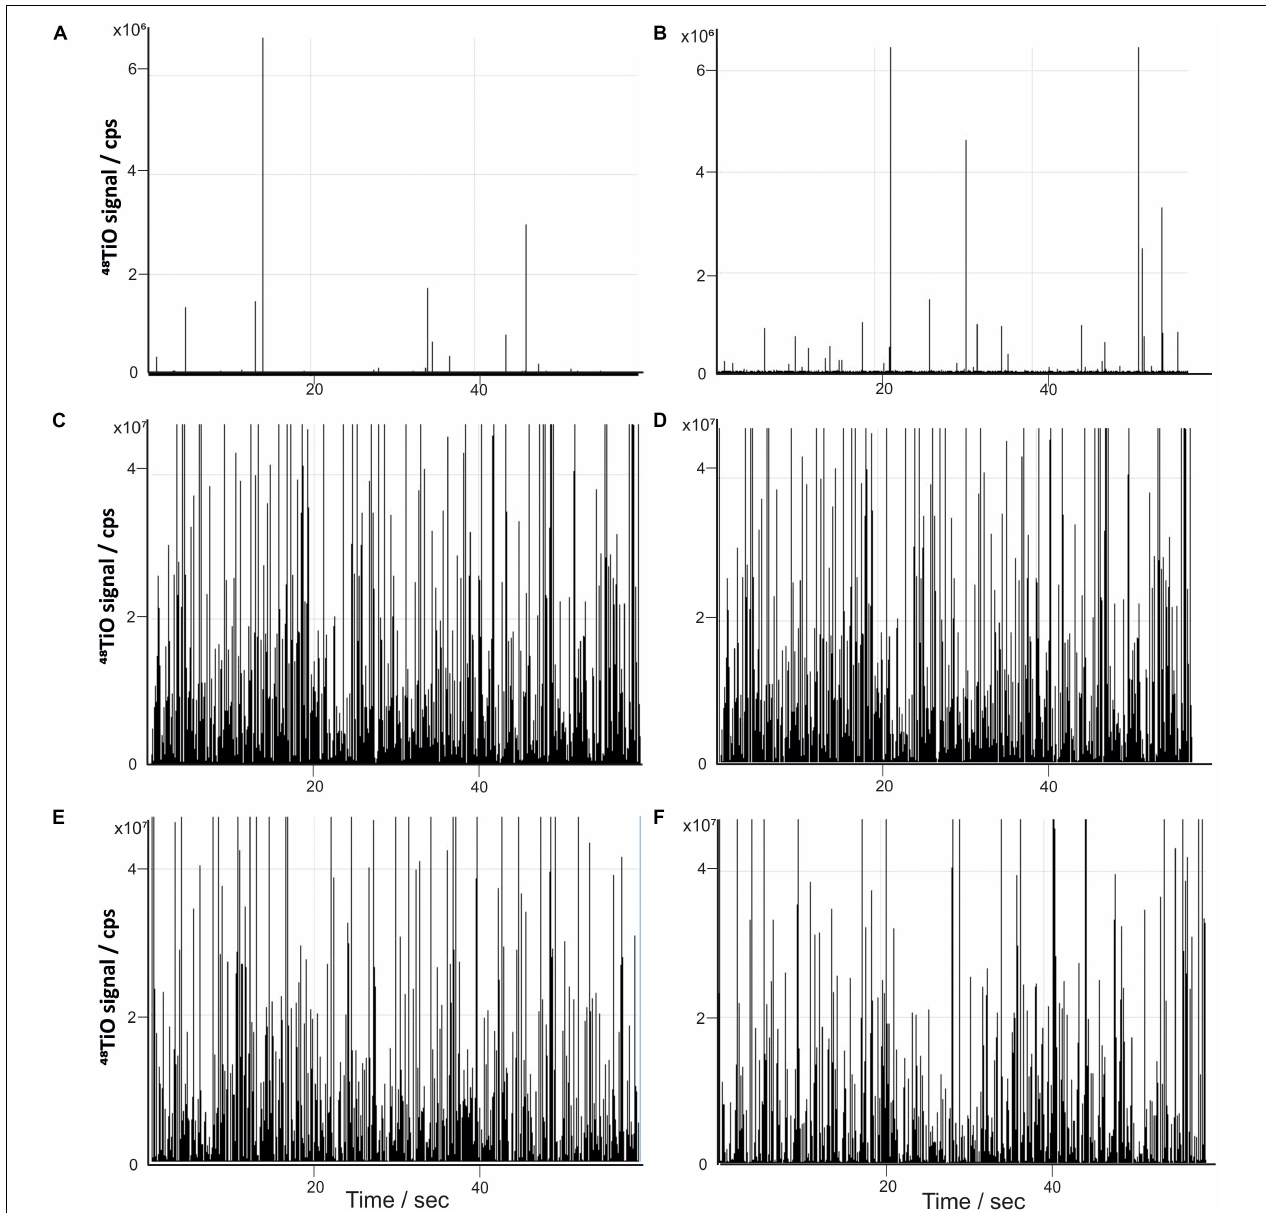
FIGURE 3 | Time scans obtained by SP-ICP-MS for (A) roots of control plants, (B) leaves plus stems of control plants, (C) roots of plants treated with TiO 2 NP suspension A, (D) leaves plus stems of plants treated with TiO 2 NP suspension A, (E) roots of plants treated with TiO 2 NP suspension B, and (F) leaves plus stems of plants treated with TiO 2 NP suspension